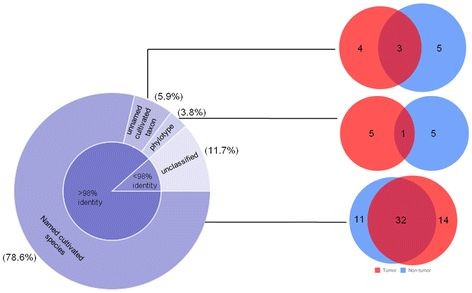
Relative distribution of total bacteria (cultivable species and uncultured phylotypes) in tissues from non-tumor and tumor sites of OSCC subjects characterized by HOMD. Core of pie chart shows percentage distribution of total 914 filtered sequences in terms of their % homology to curated 16S rRNA sequences in HOMD. Outer concentric of pie chart depicts the oral bacterial taxa in combined library; sequences with >98% identity: named cultured species (78.6%), unnamed cultured species (5.9%) and yet-uncultured phylotypes (3.8%); and sequences with <98% identity (11.7%) were considered as unclassified sequences characterized only to genus level. Venn diagrams correlates with the corresponding section of pie chart as indicated by line except for the unclassified sequences. Inset values in two subsets (non-tumor and tumor) represents observed bacterial species unique to that particular library. Values in overlapping section of subsets reflect oral taxa common to both sites.